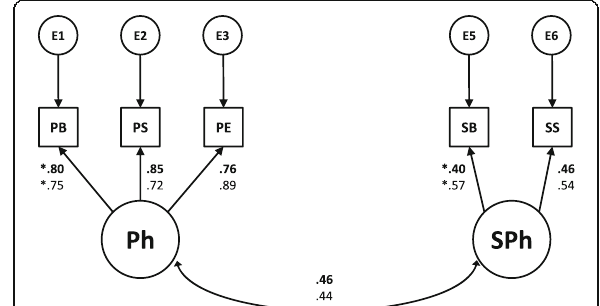
Fig. 1 Two-factor confirmatory model of phonological awareness (Model 2F:PxSP). Parameters represent standardized estimates for children in the kindergarten (upper bold parameters) and for children in the first grade (down parameters). Factors ’ correlation and all loadings from the latent constructs (Ph, SPh) to their corresponding indicators were significant (all p < .05). Ph phonemic units, PB phoneme blending, PS phoneme segmentation, PE phoneme elision, SPh supraphonemic units, SS syllable segmentation, SB syllable blending, *